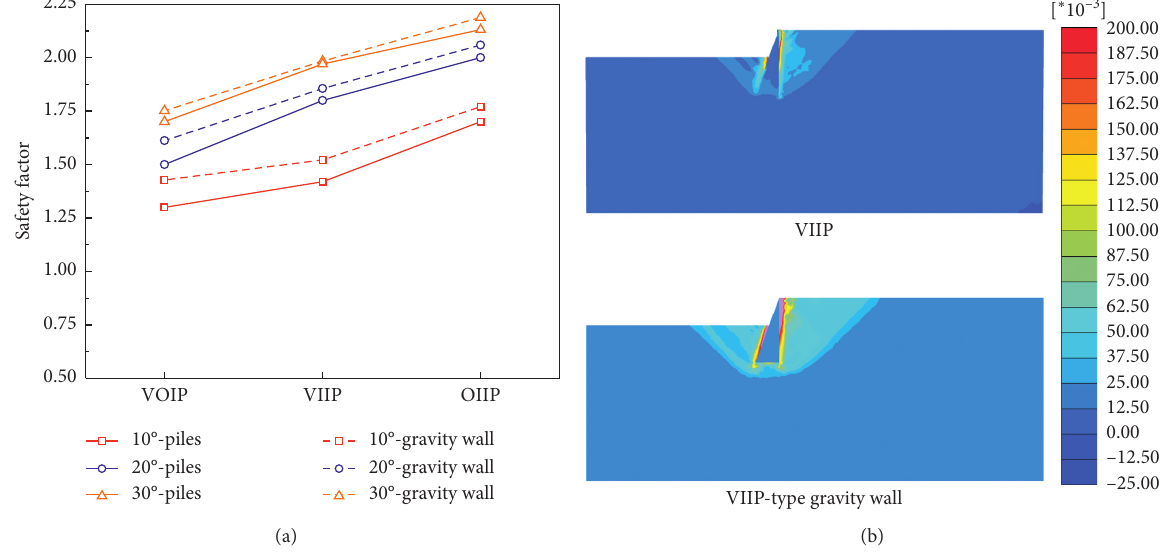
Figure 18: Comparison between CIRSs and corresponding gravity walls. (a) Safety factors. (b) Contours of shear strain increments.